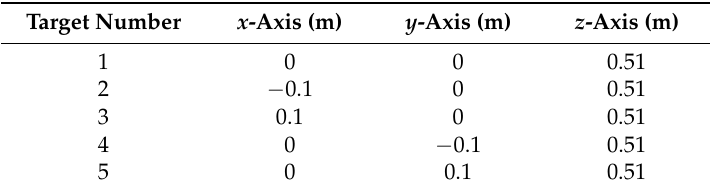
Table 2. Coordinates of ideal point targets.